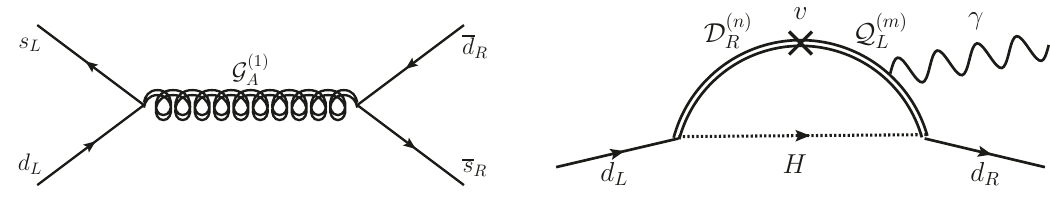
Figure 8 . The most important, new contribution to (a) CP -violation in K - K -mixing and (b) the neutron EDM. Double lines denote KK